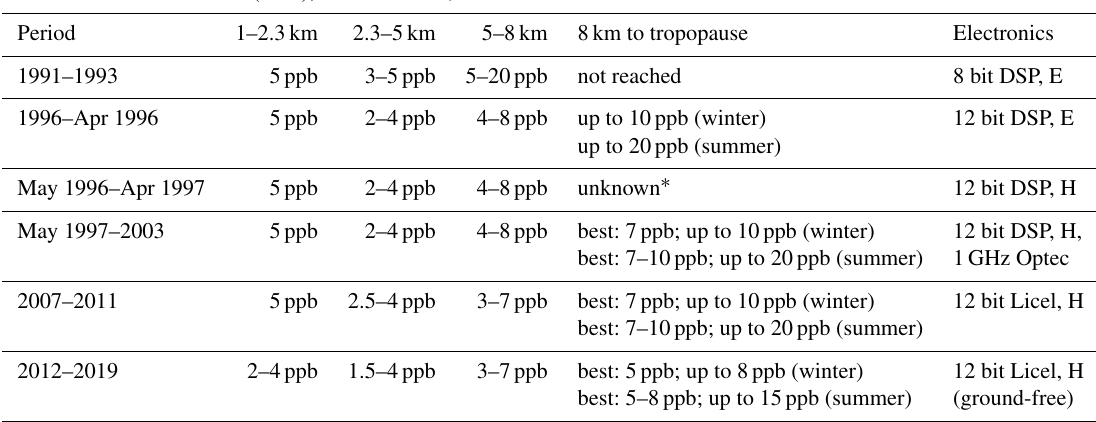
Table 4. Uncertainties of the stationary ozone